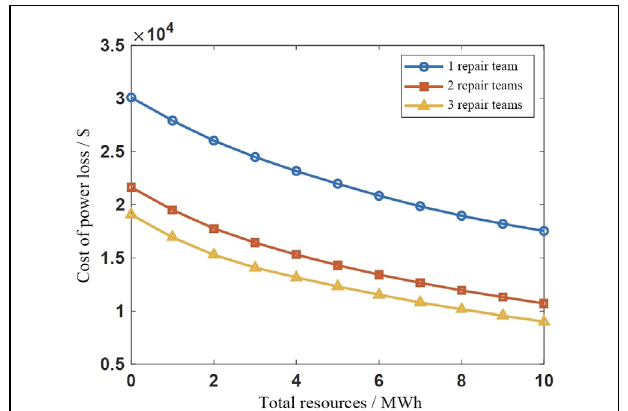
FIGURE 11 | Post-disaster power loss.